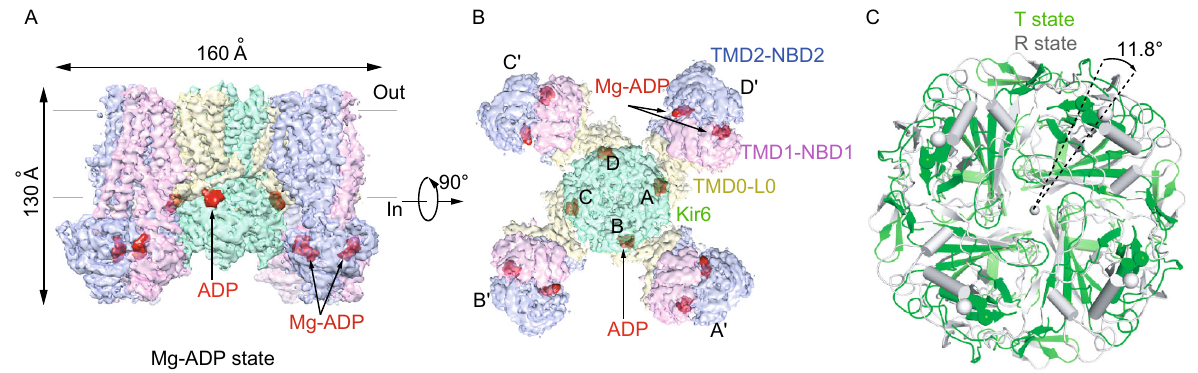
Figure 3. Structure of K ATP in the Mg-ADP state. (A) Side view of the K ATP structure in the Mg-ADP state, colored as in Fig. 1A. ADP and Mg-ADP densities are colored in red. (B) Bottom view of the K ATP channel in the Mg-ADP state. (C) Bottom view of the aligned Kir6.2 structures between “ T state ” (green) and “ R state ” (gray) of the Mg-ADP state. Rotation angle between CTDs is measured similarly as in Fig.